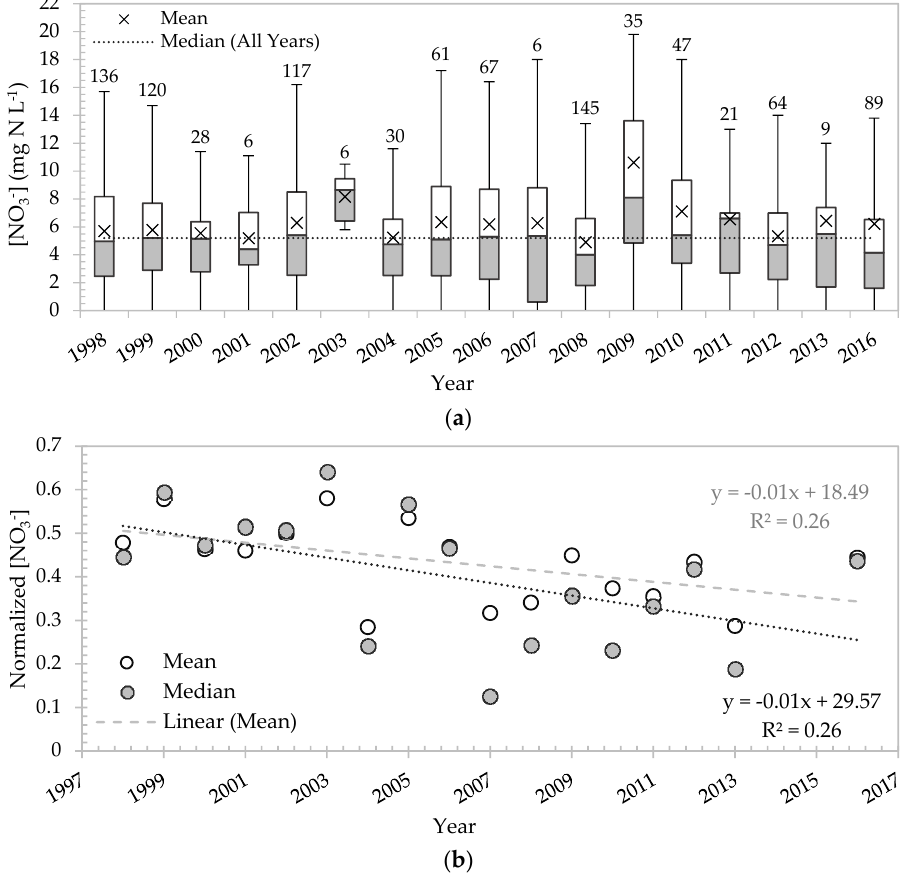
Figure 5. Nitrate data from 1998 to 2016 ( n = 987) collected and/or maintained by the North Platte Natural Resources District, Nebraska Agricultural Contaminant Database, and the current study: ( a ) a Box ‐ and ‐ Whisker plot of all nitrate data, including the number of samples collected each year (referenced above the maxima) and long ‐ term median of each annual median; and ( b ) mean and median of normalized annual Dutch Flats groundwater nitrate.